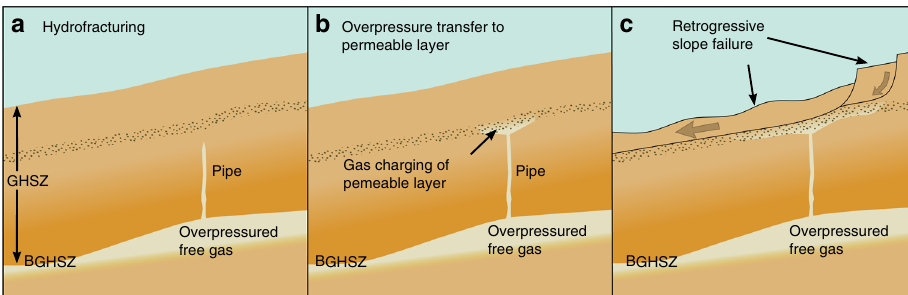
Fig. 4 Schematic evolution of retrogressive slope failure due to overpressured gas below the GHSZ: a submarine slope with gas hydrate-bearing sediments (gradually decreasing saturation from the bottom of the GHSZ) and overpressured gas (bright area) at the bottom of the GHSZ (BGHSZ) induces pipe generation into the GHSZ, b the conduit encounters a permeable layer; gas enters and leads to overpressure transfer from the bottom of the GHSZ to the shallow subsurface, c overpessured gas causes shear banding in the weak layer and generates retrogressive slope